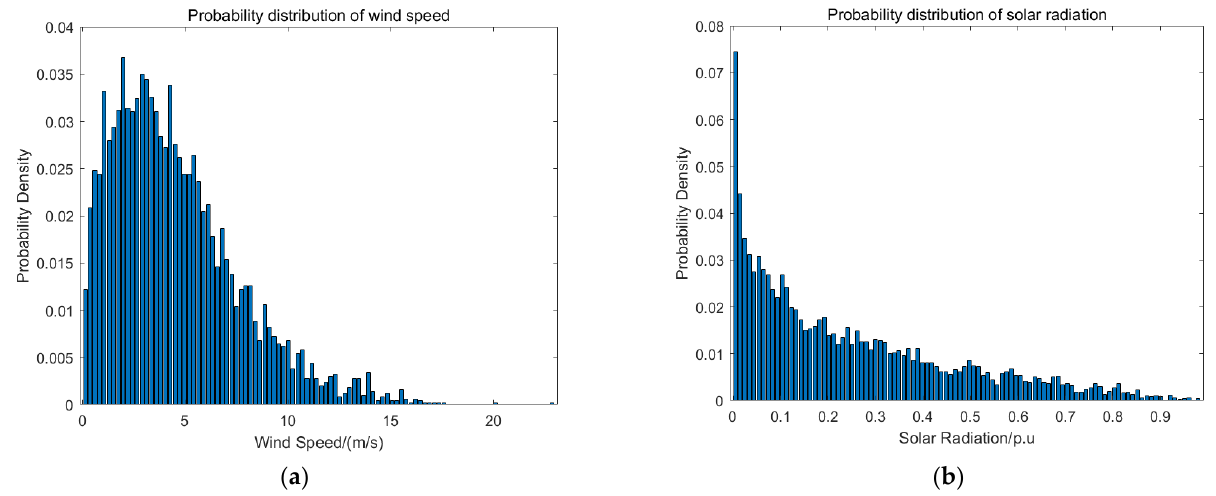
Figure 5. ( a ) Weibull distribution of wind speed; ( b ) beta distribution of solar radiation.